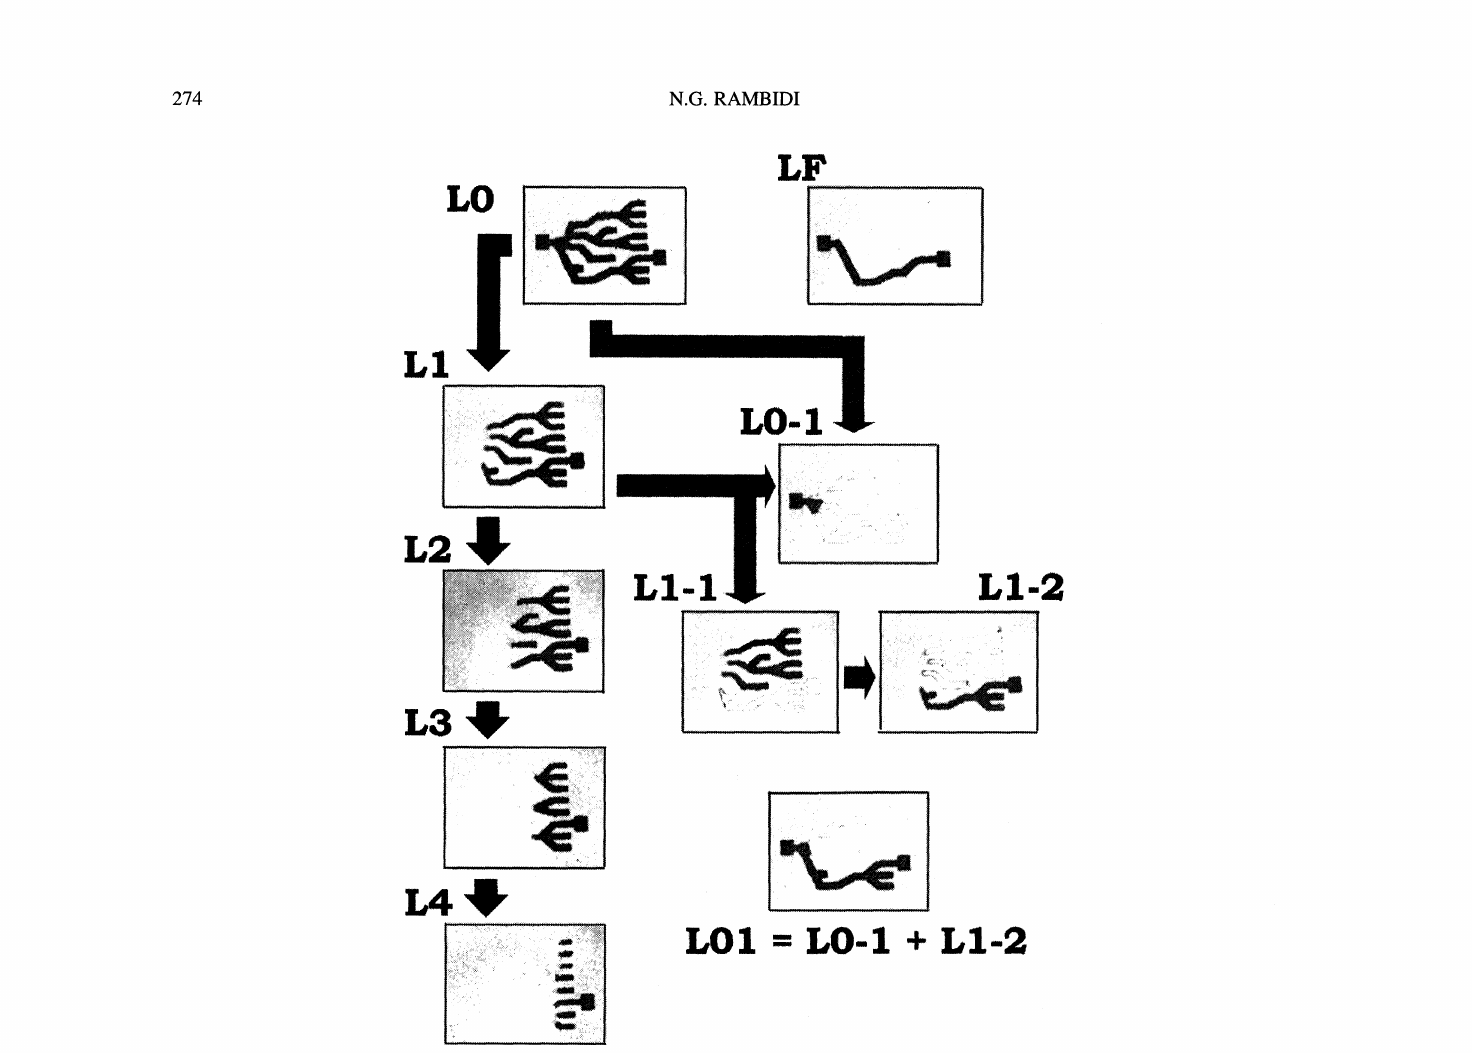
FIGURE 6 Finding shortest path in a simple tree-type labyrinth. L0 is an initial image of the labyrinth in the Belousov-Zhabotinsky type medium, L1-L4: some consecutive steps of its evolution in the process of the wave spreading, LF: the image of the shortest path in the labyrinth, L0-1 is the pathway which the wave has passed during the first step of its spreading, L1-1 is the result of Paint Bucket operations for L1 image, L1-2 presents result of subtraction of non-connected with target point parts from the L1